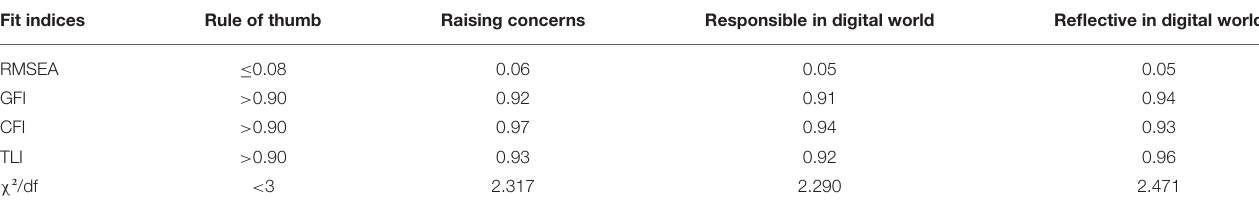
TABLE 6 | The goodness of fit indices used to signify model fitness (n = 59).